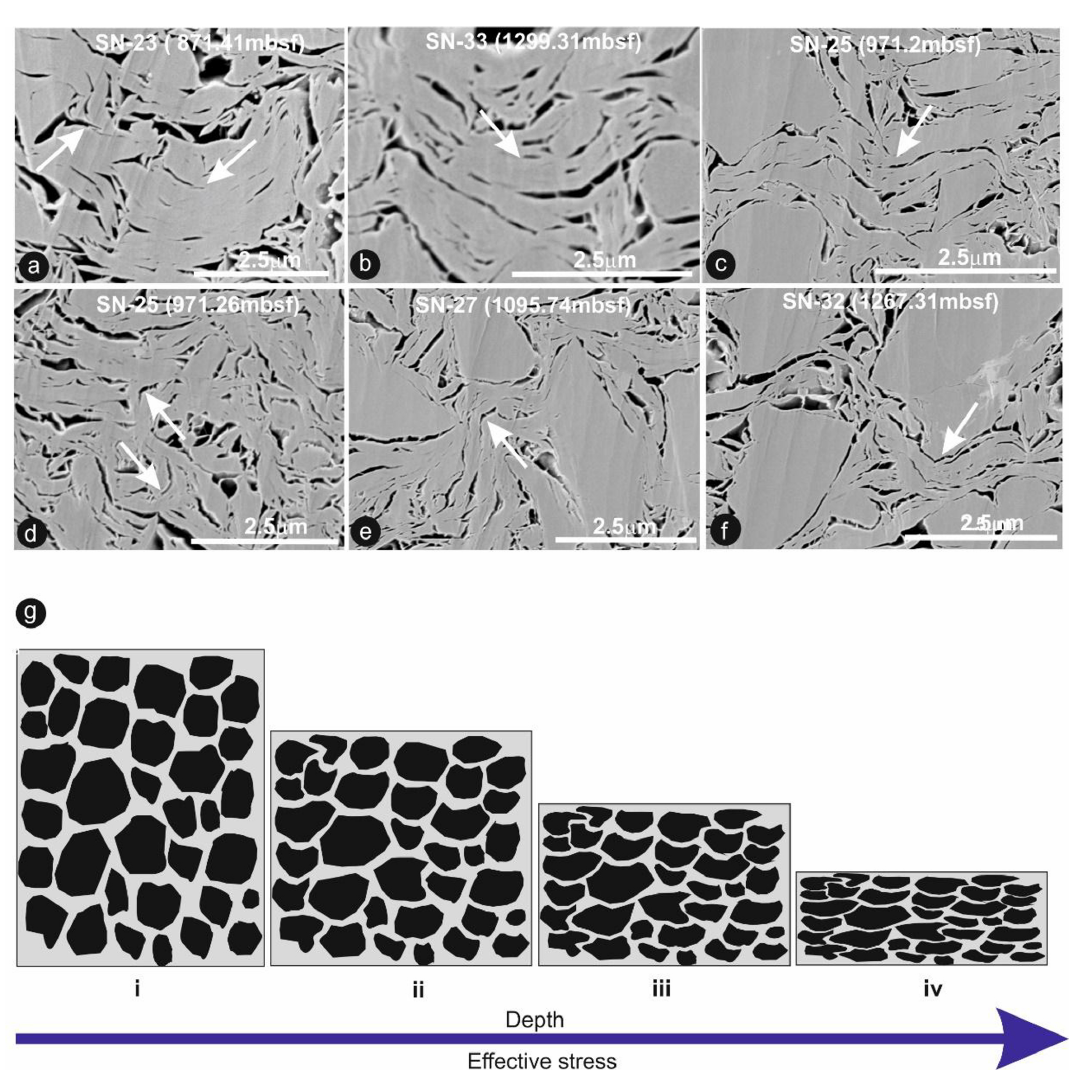
Figure 14. (a–f) Examples of clay aggregate bending (white arrows). (g) Conceptual diagram tracing porosity reduction and an increase in preferred alignment of the long axes of pores by bending of clay perpendicular to applied vertical